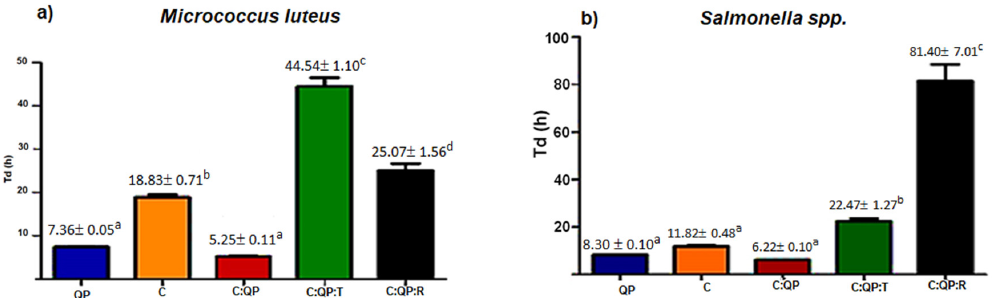
Figure 2. Effect of biopolymers alone, combined, and incorporated with EOs on doubling time of ( a ) Micrococcus luteus ; ( b ) Salmonella sp. T d : doubling time; QP: quinoa protein; C: chitosan; T: thyme essential oil 0.5% ( v / v ); R: rosemary essential oil 1% ( v / v ). Data are presented as the mean ± standard deviation. a-d Indicate significant difference ( p < 0.001).